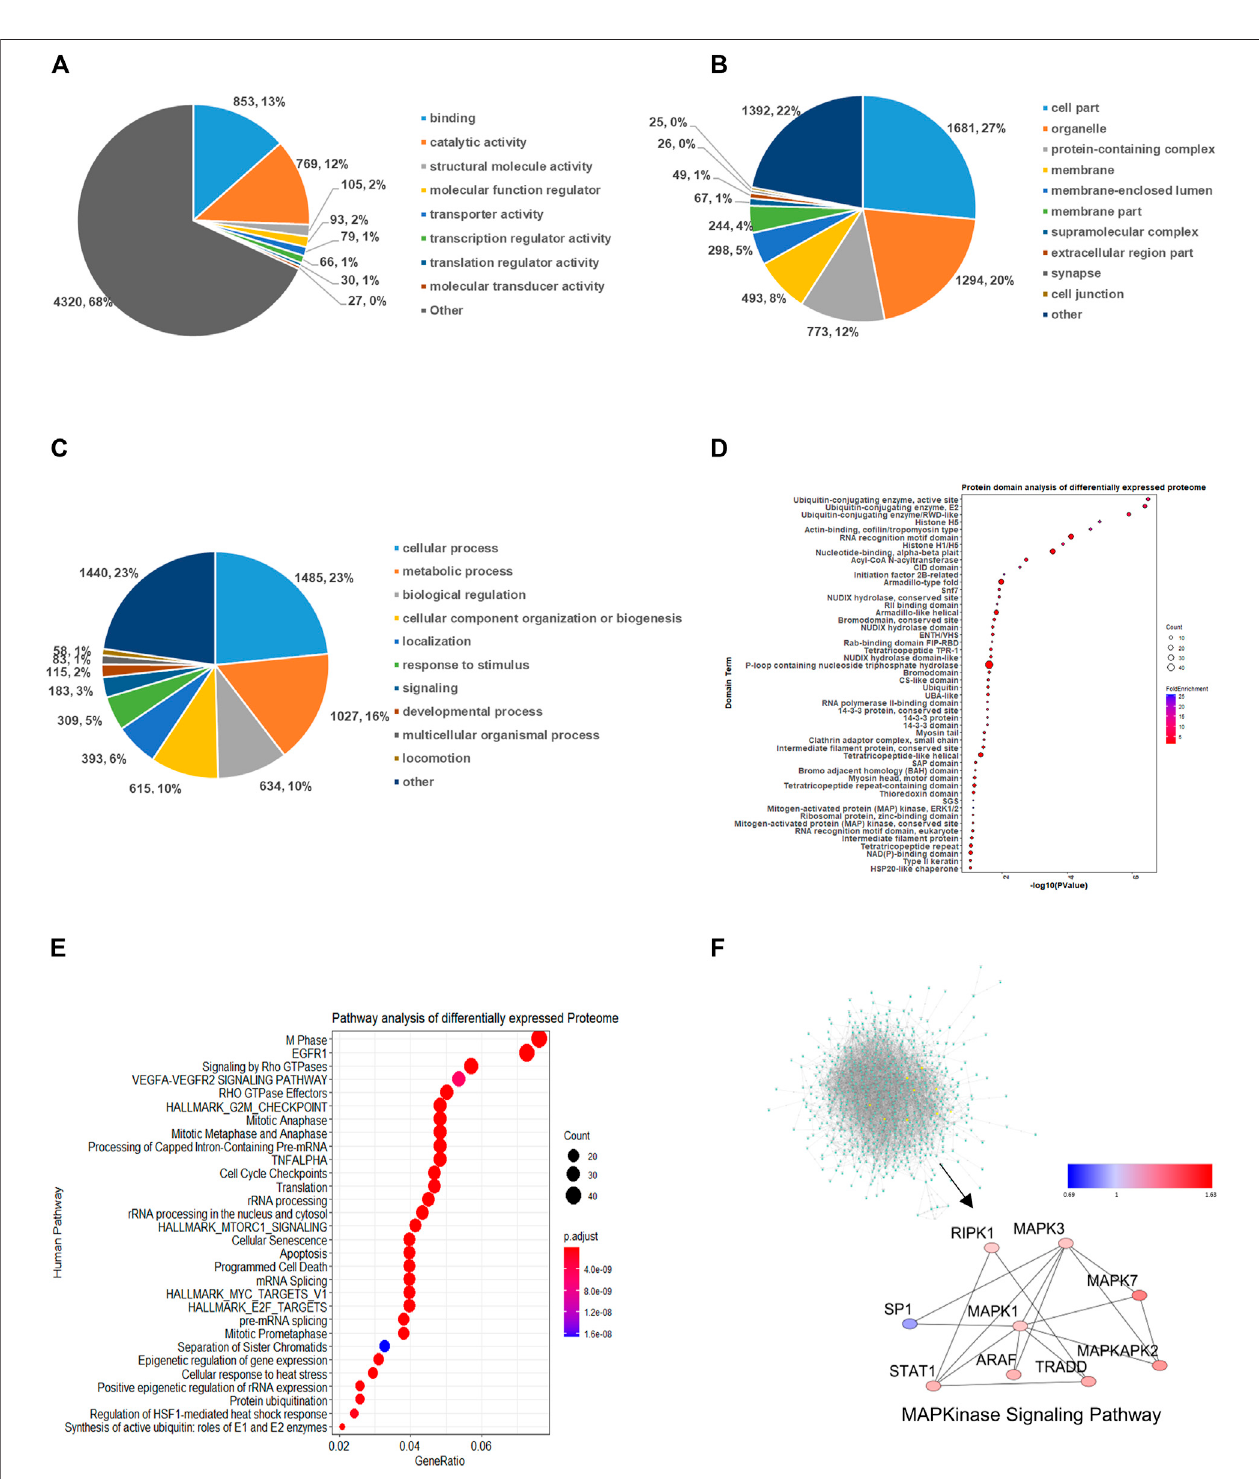
FIGURE 1 | Functional enrichment cluster analysis of quanti fi ed global proteome. (A) Molecular function. (B) Cellular compartment. (C) Biological process. (D) Proteindomainanalysis. (E) KEGGpathwayenrichmentanalysisofdifferentiallyexpressedproteins. (F) Protein – proteininteractionnetworkofproteome.Theglobalview and representative MAPK pathway are